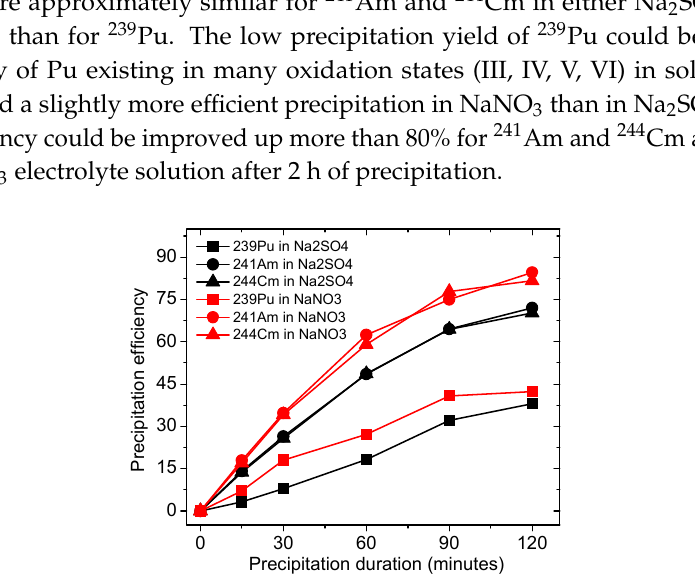
Figure 7. Electro-precipitation kinetic of the mixture ( 239 Pu, 241 Am and 244 Cm) in: ( i ) 0.3 M Na 2 SO 4 at pH 3.5 electrolyte solution with a current density of 5 mA.cm − 2 and ( ii ) 0.3 M NaNO 3 at pH 3.0 electrolyte solution with a current density of 2.5 mA.cm − 2 .